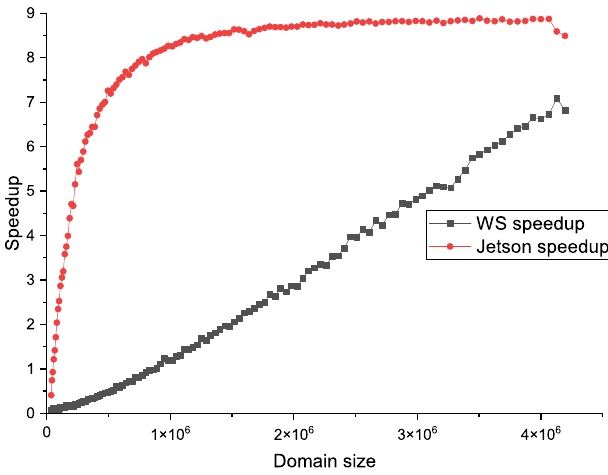
Figure 11. Speedup for GPU mode vs. multi-CPU